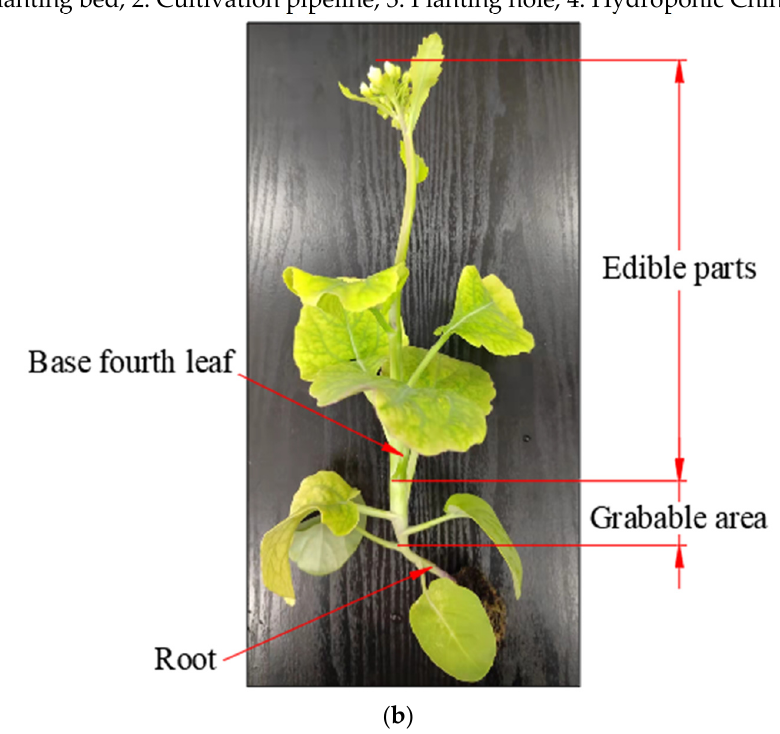
Figure 2. Growing conditions of hydroponic Chinese kale: ( a ) the hydroponic Chinese kale planted in the greenhouse cultivation pipeline; ( b ) the main structural features of hydroponic Chinese kale.